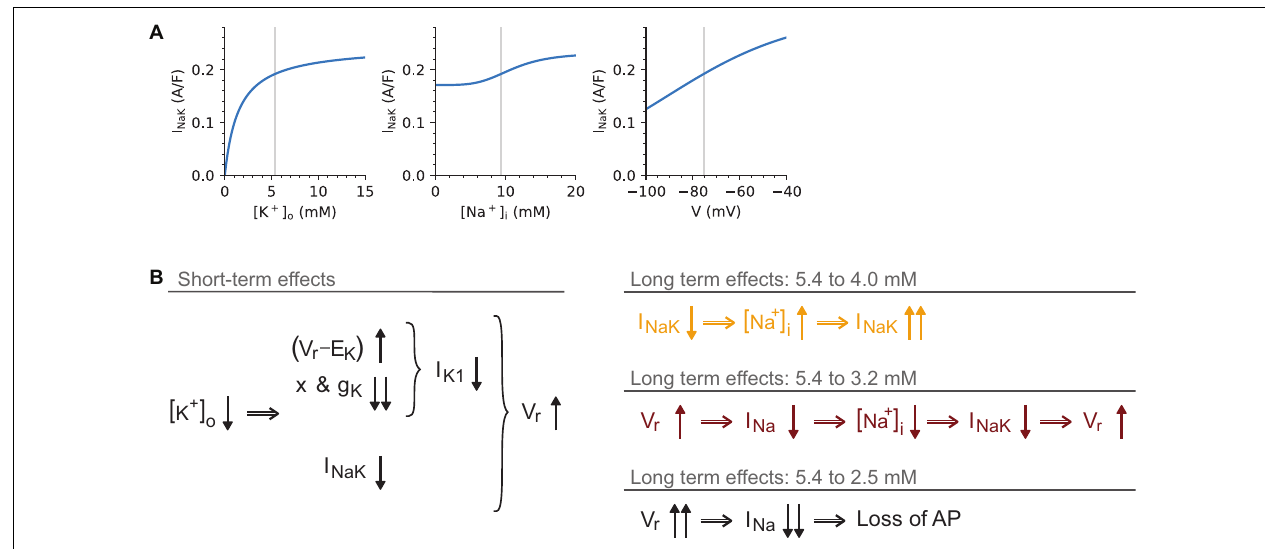
FIGURE 6 | Qualitatively different long-term effects of different [K + ] o changes. This diagram summarizes the origins of the contrasting short- and long-term effects seen in Figure 4 . (A) illustrates the sensitivity of I NaK to [K + ] o (left), [Na + ] i (center), and V r (right), as determined from the Voigt-Heijman model under baseline conditions. The schematic in (B) shows the immediate (left) and delayed (right) effects of [K + ] o changes. The short-term effects are similar in all cases: a step change in [K + ] o causes an increased electrochemical driving force for I K1 at potentials near V r , this causes an increase in I K1 . However, this effect is overshadowed by the I K1 decrease due to the effects of [K + ] o on I K1 rectification and maximum conductance. In response to lower [K + ] o , I NaK shows an instantaneous decrease, and together these effects cause a depolarization of V r in all tested [K + ] o levels. In the long-term, however, the effect is size-dependent: For small decreases (5.4 to 4 mM), the effect is dominated by the initial reduction in I NaK , which leads to an increased Na + influx. This, in turn, causes [Na + ] i to rise progressively and I NaK to increase until Na + balance is restored. For larger decreases in [K + ] o (5.4 to 3.2 mM) the effects of V r depolarization on I Na “availability” become dominant. The depolarized V r reduces I Na availability, so that both peak current and Na + influx through I Na is decreased, causing a reduction in [Na + ] i . This in turn further reduces I NaK until its Na + efflux once again matches the (reduced) influx. In this case, balance is restored, but at a depolarized V r level, which markedly reduces excitability. Finally, for the largest reduction in [K + ] o studied (5.4 to 2.5 mM), this same pattern develops, but at a faster rate until the depolarization of V r reaches a point where I Na availability is too low to support an I Na -driven